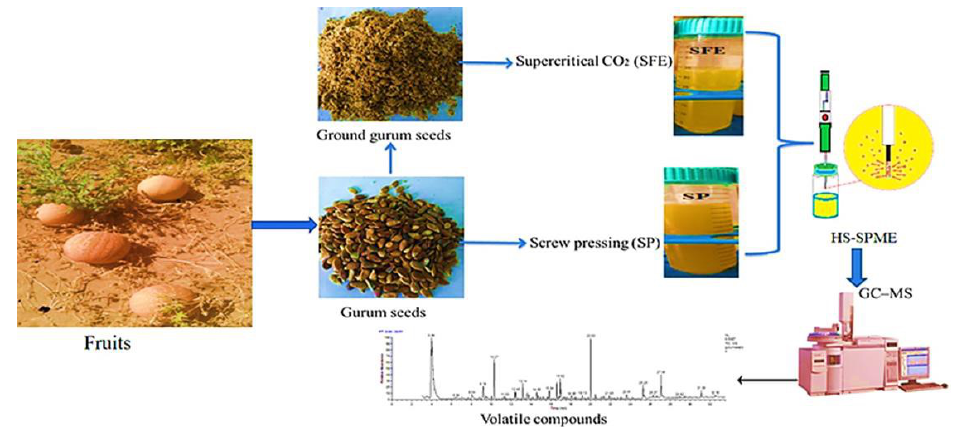
Figure 1. Schematic representation.